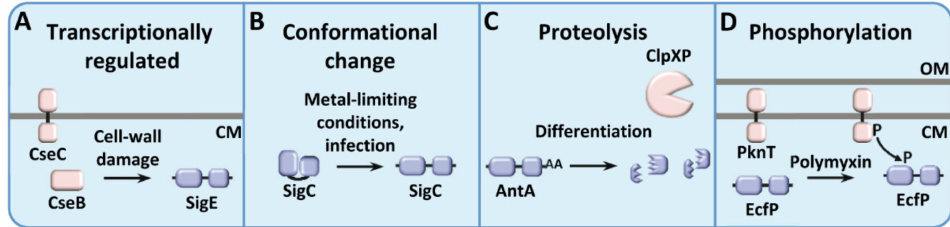
Figure 2. Examples of described regulatory mechanisms in ECF sigma factors non-associated to an anti-sigma factor. ECF sigma factors are depicted in blue, whereas additional regulatory proteins are depicted in pink. ( A ) SigE from S. coelicolor is transcriptionally regulated by the two-component system CseBC, which responds to cell wall damage; ( B ) SigC, involved in virulence of M. tuberculosis , is regulated by a conformational change under infection conditions; ( C ) AntA from S. albus is degraded by ClpXP during certain stages of the life cycle; ( D ) EcfP from V. parahaemolyticus is activated by phosphorylation by the STPK PknT in response to the antibiotic polymyxin. OM: outer membrane; CM: cytoplasmic